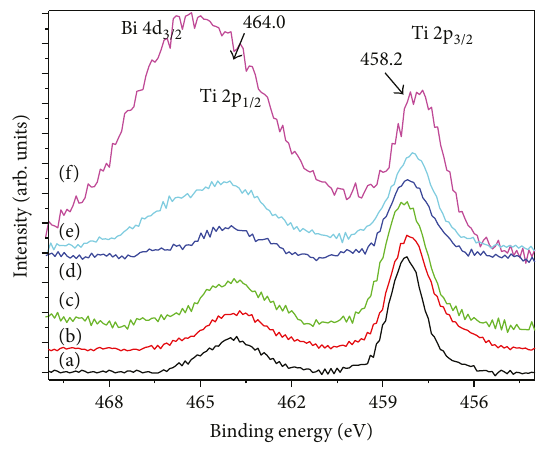
Figure 4: Ti 2p region spectra evolution as a function of